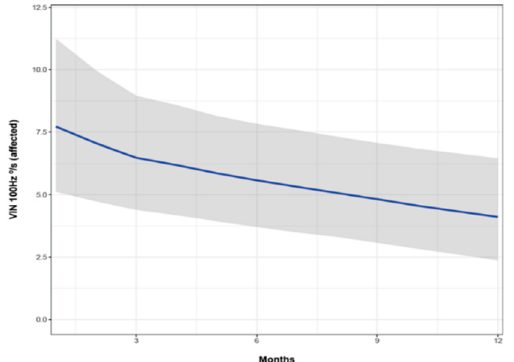
Figure 2. Follow-up of slow phase velocity (SPV) of skull vibration-induced nystagmus (SVIN). Vertical axis: SPV of SVIN at 100 Hz (in the ear affected). Horizontal axis: time in months. The line shows the value of the SVIN SPV estimate, and the shaded area indicate the confidence interval (IC).